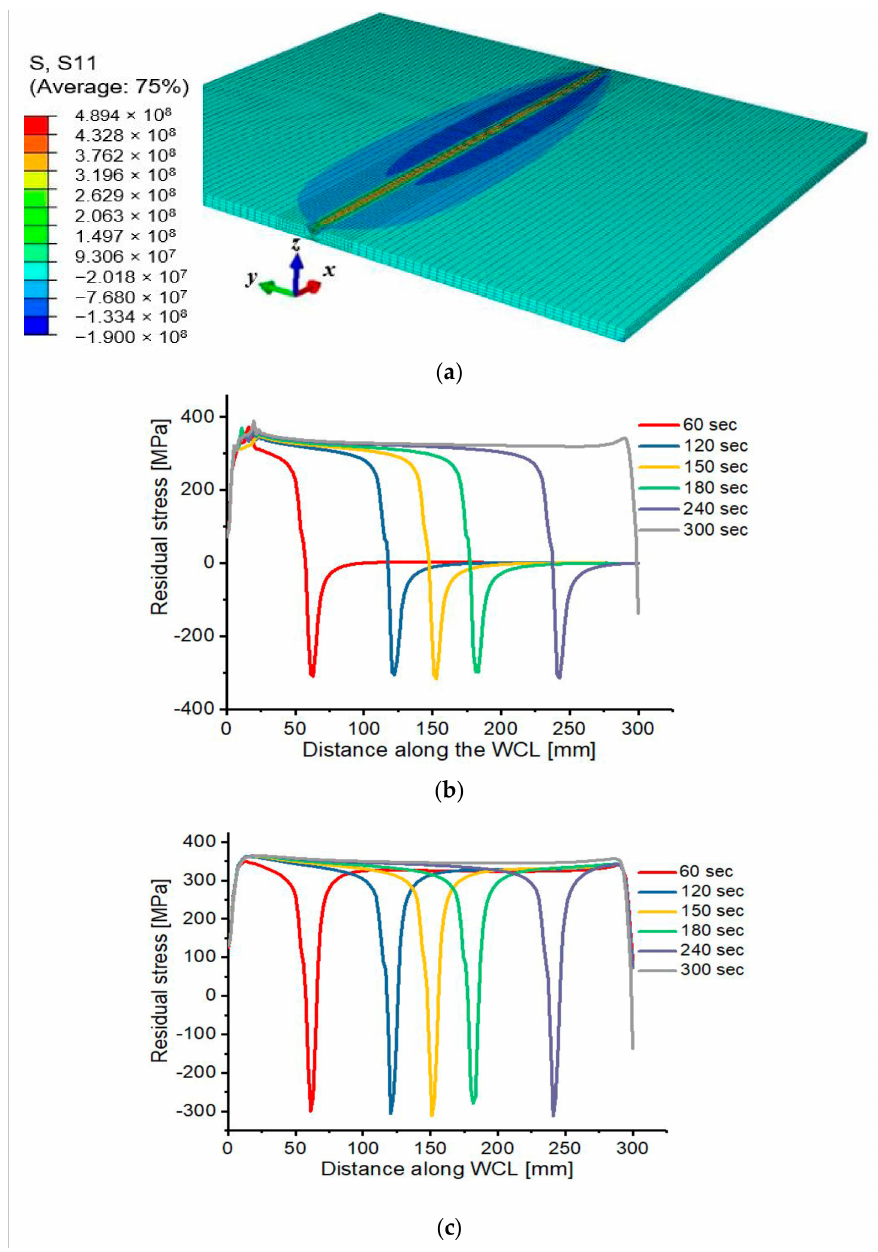
Figure 15. ( a ) Residual stress distribution ( b ) Residual stress evolution during the first pass ( c ) Residual stress evolution during the second